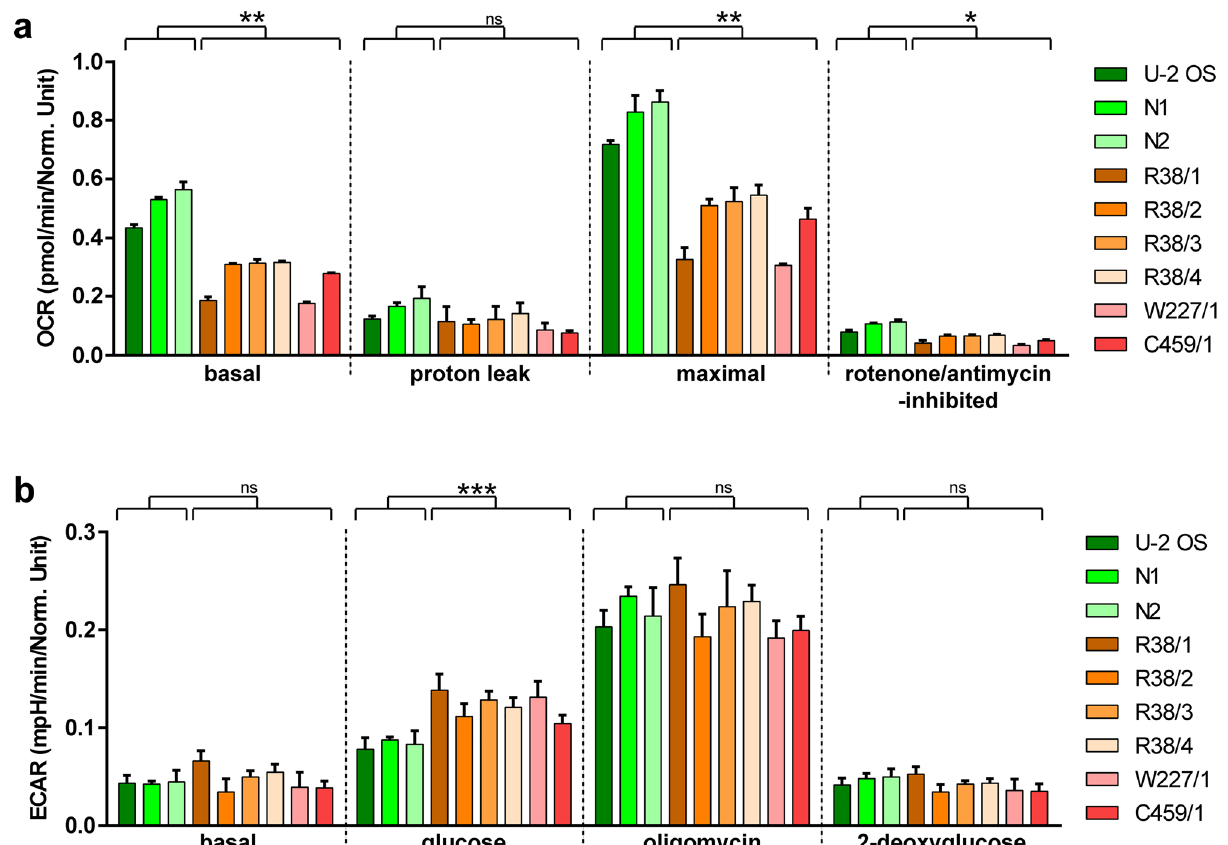
Figure 5. Analysis of mitochondrial respiration and glycolytic function. Oxygen consumption rate ( a ) and extracellular acidification rate ( b ) were estimated in PPO-KO clones and PPO knock-in cell lines by Seahorse extracellular flux analyzer. ( a ) ATP production, maximal respiration and spare respiratory capacity was driven by sequential treatment with 1 µM oligomycin, 1 µM CCCP, and 0.5 µM rotenone + 0.5 µM antimycin, respectively. ( b ) Basal glycolysis, glycolytic capacity and glycolytic reserve was induced by 10 mM glucose, 1 µM oligomycin, and 50 mM 2-deoxyglucose, respectively. Statistical significance was calculated by unpaired parametric t-test with Welch’s correction and assigned by ***(P < 0.001), **(P < 0.01), *(P < 0.05) and ns (non- significant; P >